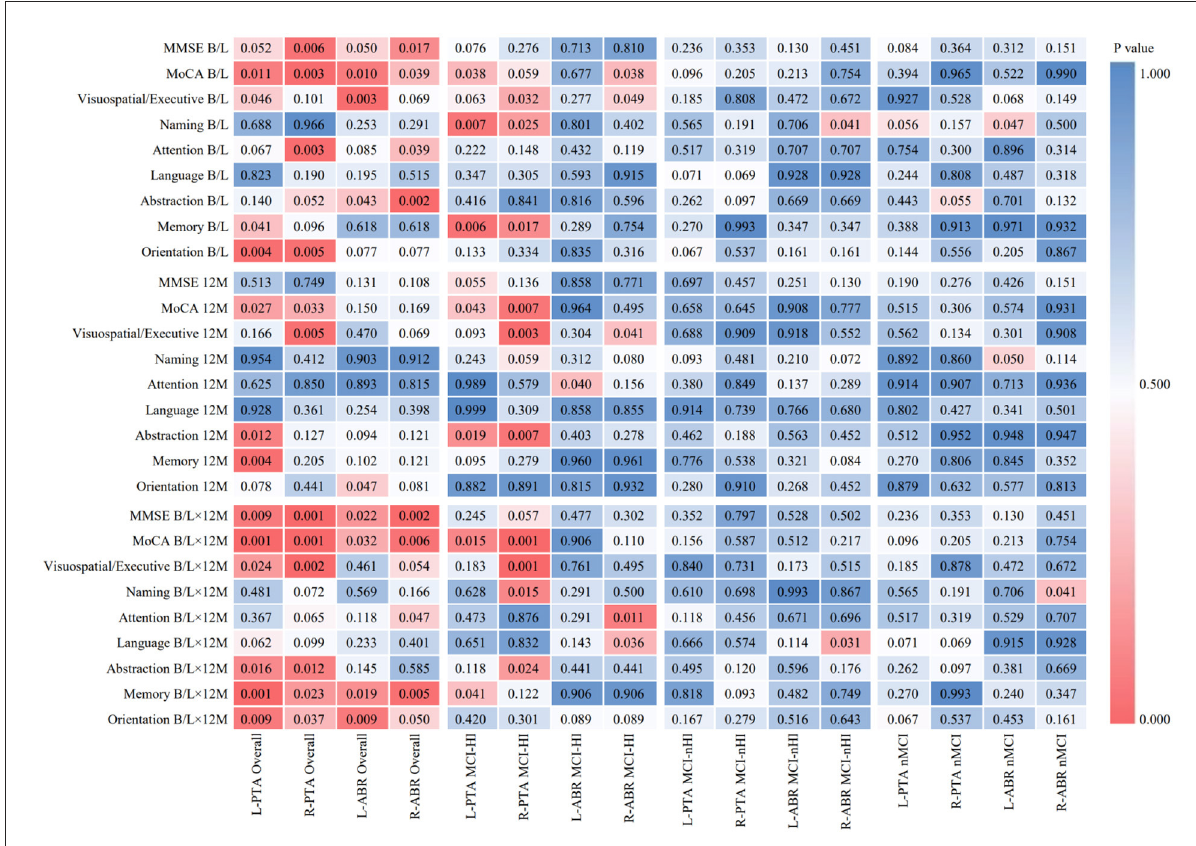
FIGURE1 Heat map of correlation analysis between hearing and cognitive functions in different periods. MCI-HI, Mild cognitive impairment with hearing impairment; MCI-nHI, Mild cognitive impairment without hearing impairment; nMCI, No mild cognitive impairment; MMSE, Mini-Mental State Examination; MoCA, Montreal Cognitive Assessment (The Montreal Cognitive Assessment, MoCA, a brief screening tool for mild cognitive impairment), PTA, Pure tone audiometry, ABR, Auditory brainstem response; B/L, Baseline; 12M, 12-month; B/L × 12M, Baseline PTA and ABR scores × 12-month MMSE and MOCA